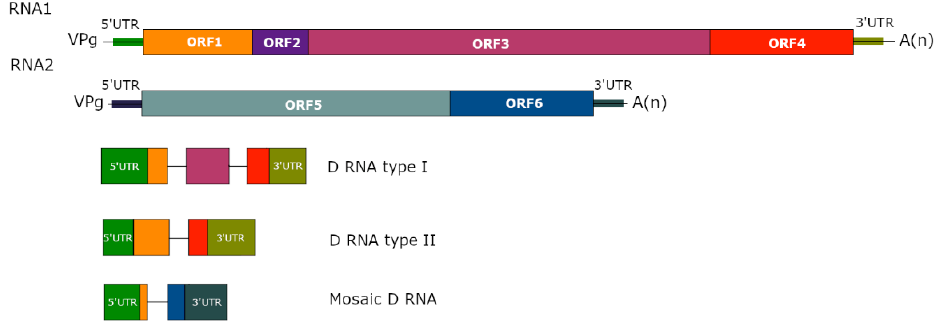
Figure 1. The general representation of different types of D RNAs associated with RNA plant viruses. The colours of different D RNA fragments represent corresponding fragments in HV. The black lines represent the recombination breakpoints.